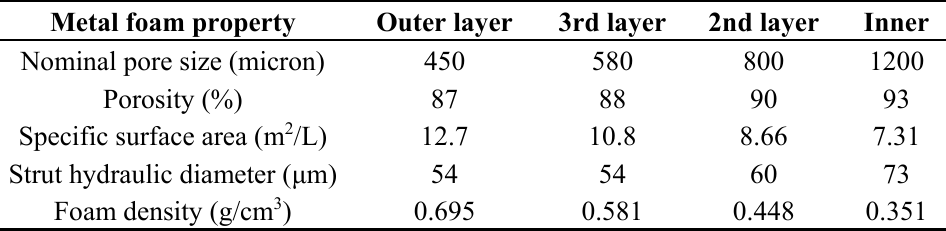
Table 3. Representative properties of the metal foam